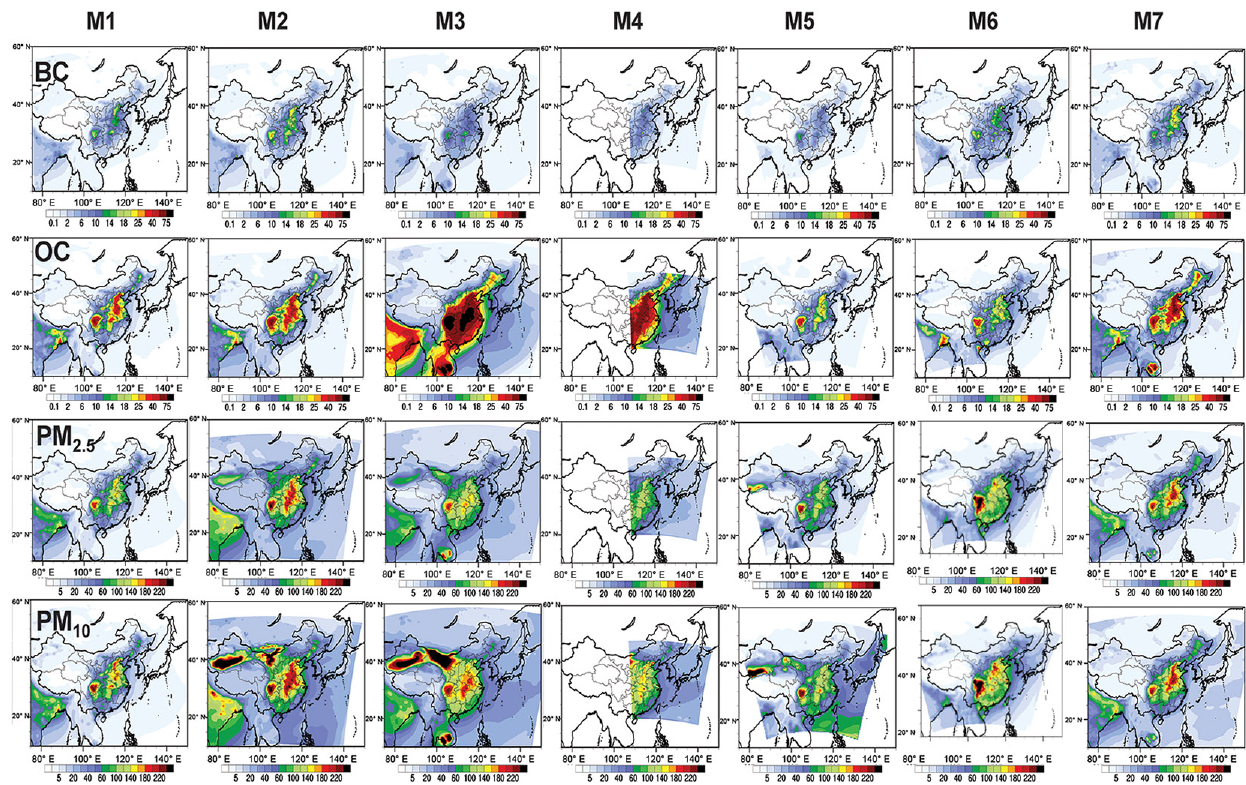
Figure 8. Simulated monthly concentrations of PM 2 . 5 and major PM 2 . 5 components (µgm − 3 ) for January 2010 from all participating models.